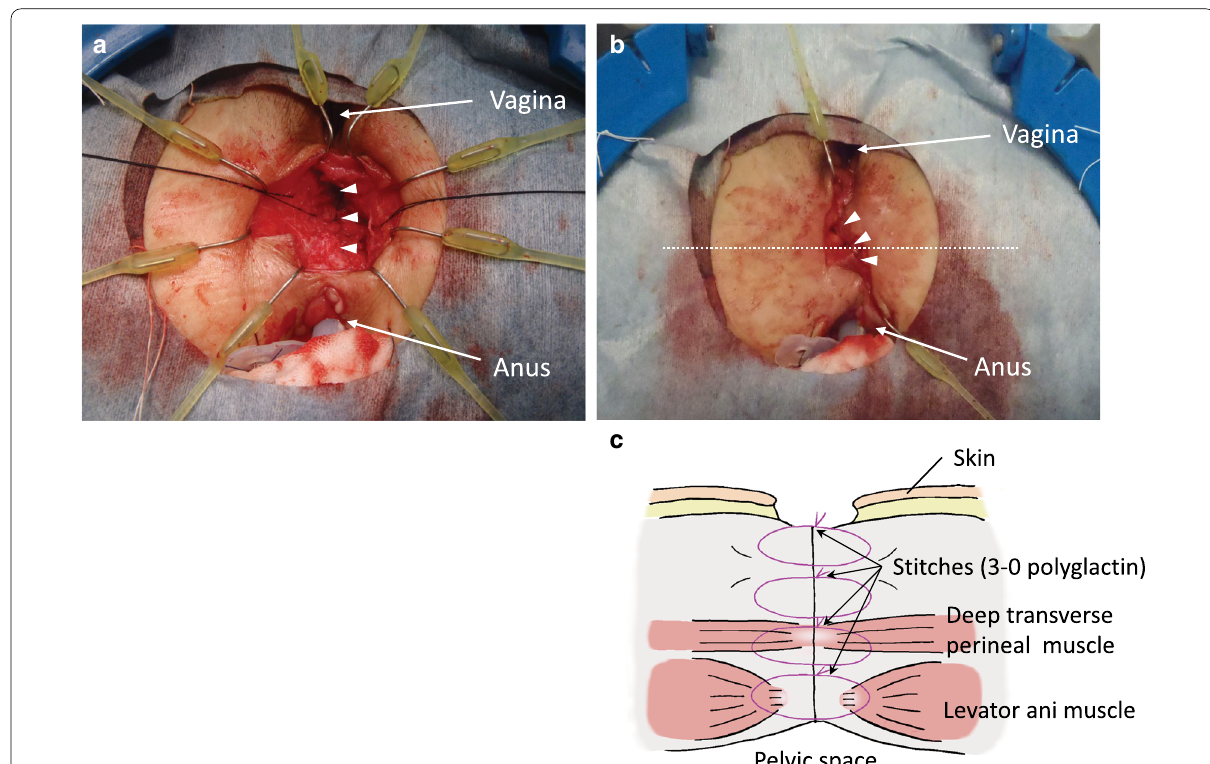
Fig. 6 a Innermost portion of the dissected connective tissue was sutured longitudinally by making three stitches (arrow heads). b After the repair and interposition of the dissected connective tissue. The outermost layer was also sutured by making three stitches (arrow heads). c Illustration at the cross section of the dotted line in